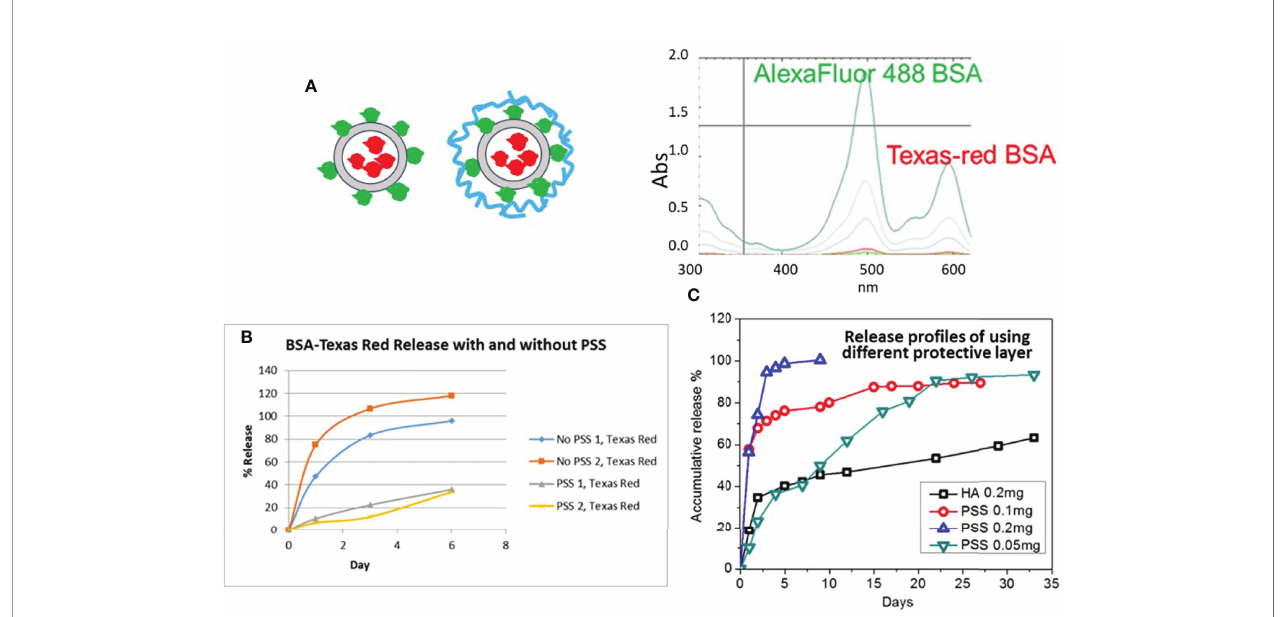
FIGURE 3 | (A) Schematic of dye Alexa Fluor 488 (green) and Texas-red labelled BSA LbL loading on NPs (red circle) by two approaches without and with second protection layer coating (Blue); UV-Vis spectra of two dye labelled protein mixture. (B) Release pro fi le of NP formulation with and without PSS as the protective layer. (C) Release pro fi le of LbL NP formulation with different mass amount of PSS or HA as the protective